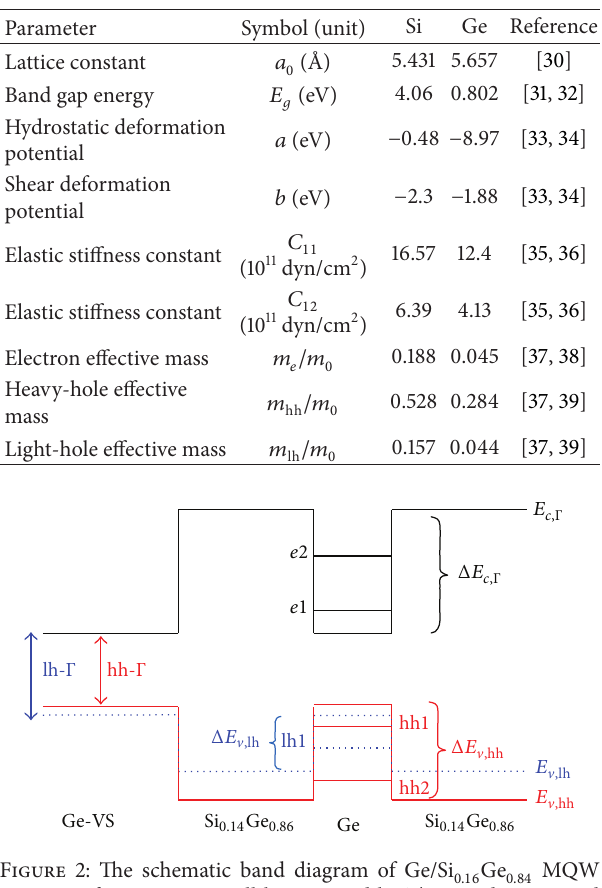
Figure 2: The schematic band diagram of Ge/Si 0.16 Ge 0.84 MQW structure for 11/26nm well/barrier width. The conduction and valence band edges and electron, and heavy- and light-hole quantum-confined states are